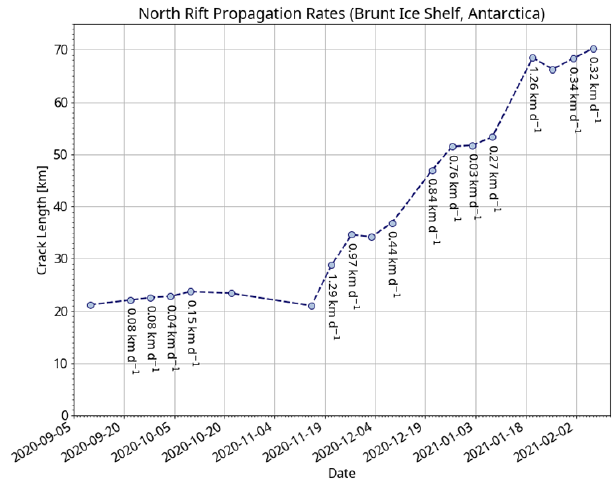
Figure 10. North Rift propagation